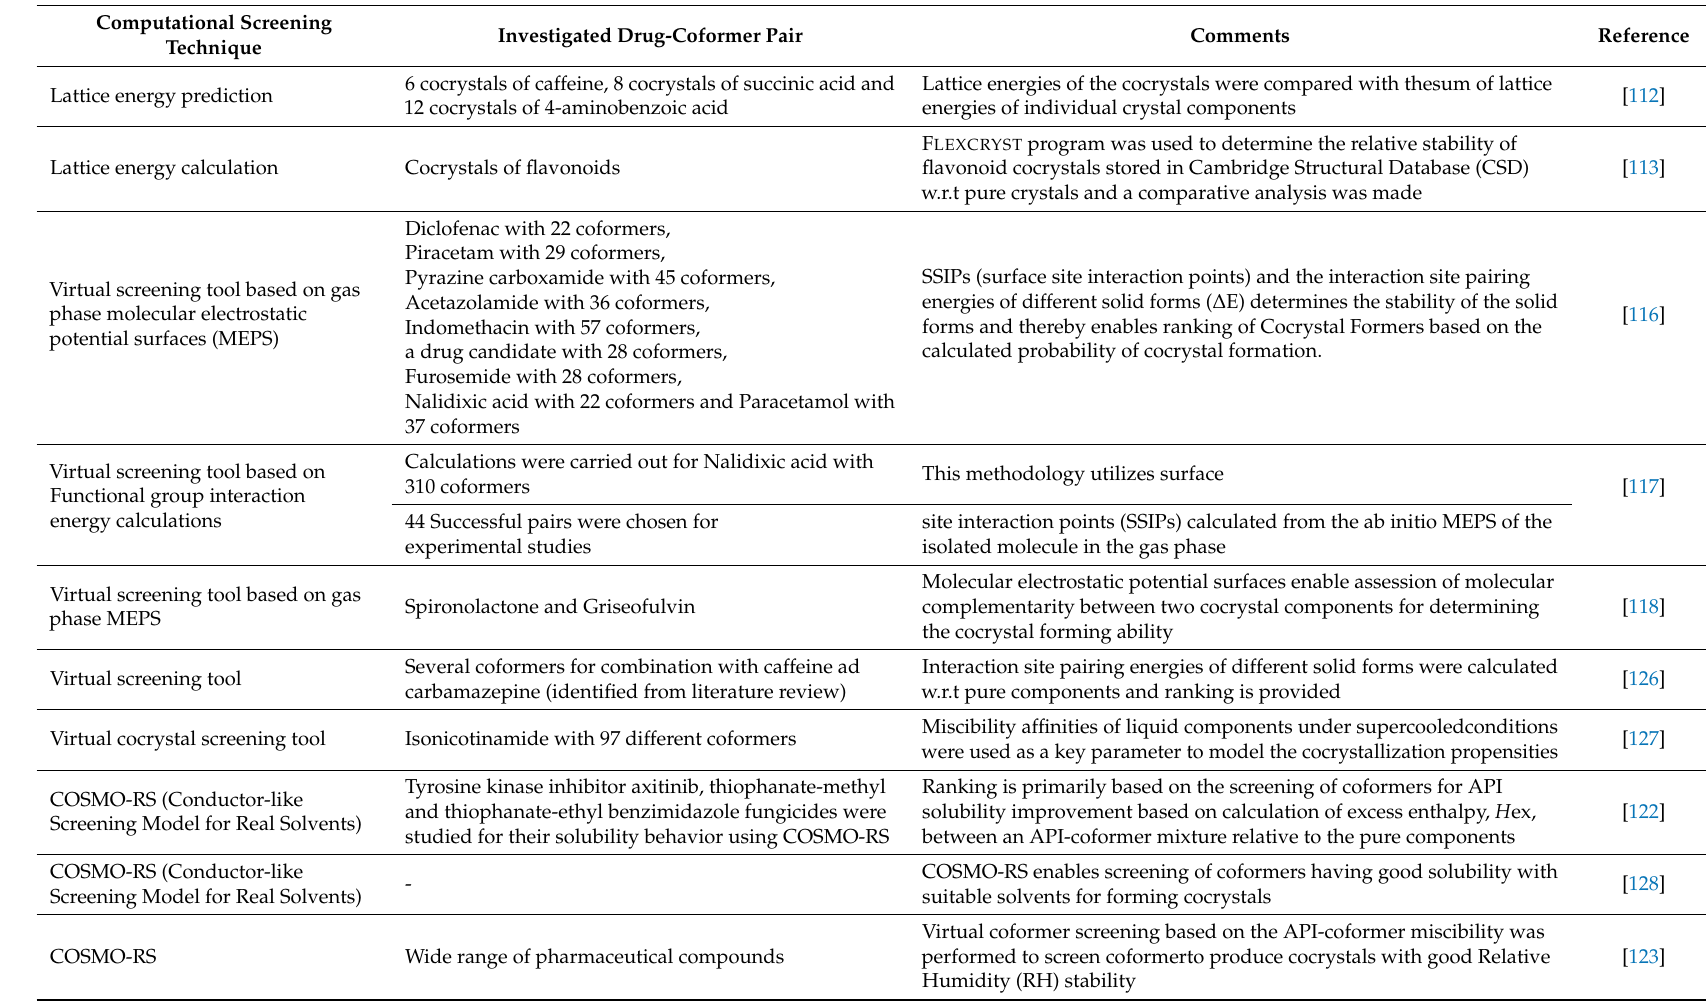
Table 6. Summary or reports available in the literature on computational screening of